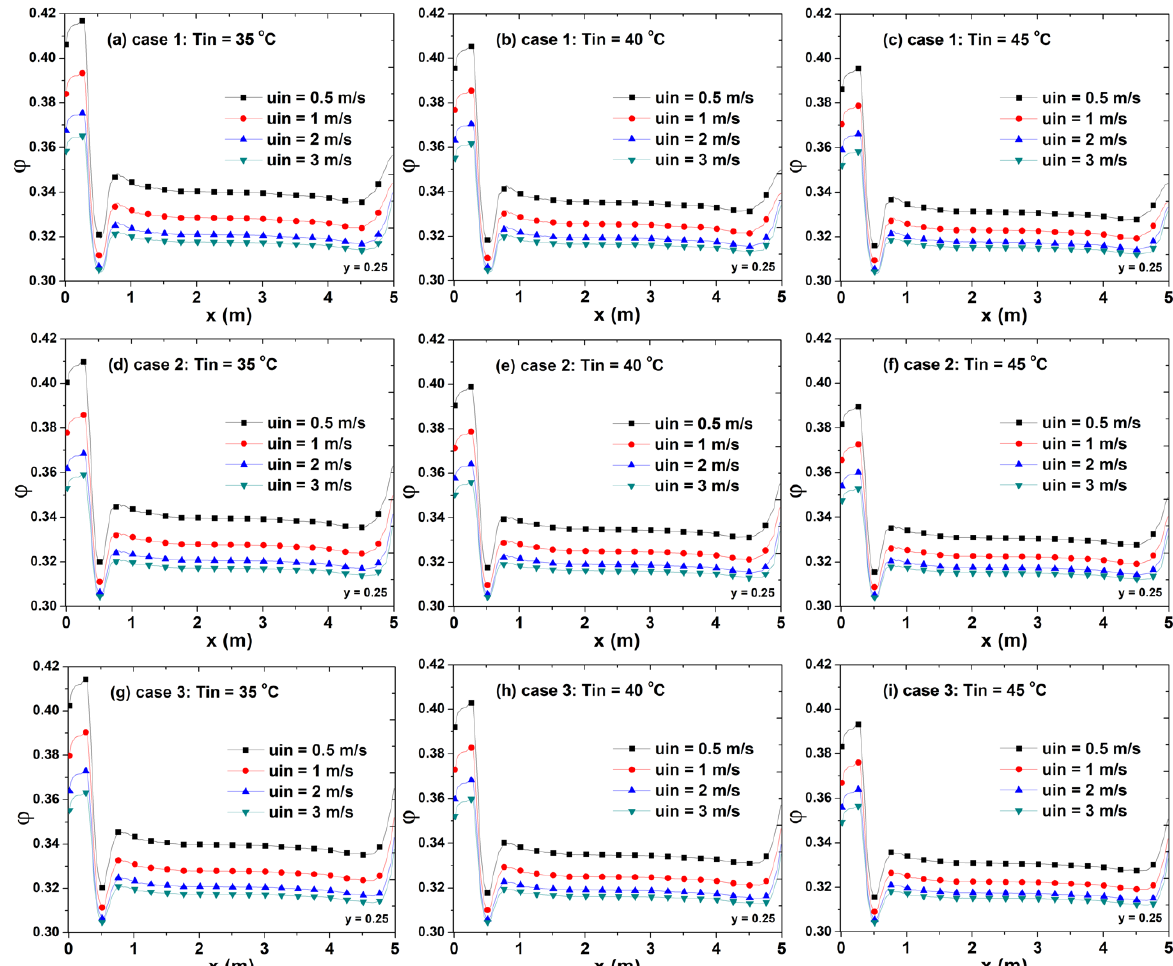
Figure 7. Relative humidity profiles at y = 0.5 m for various inlet velocities and temperatures.